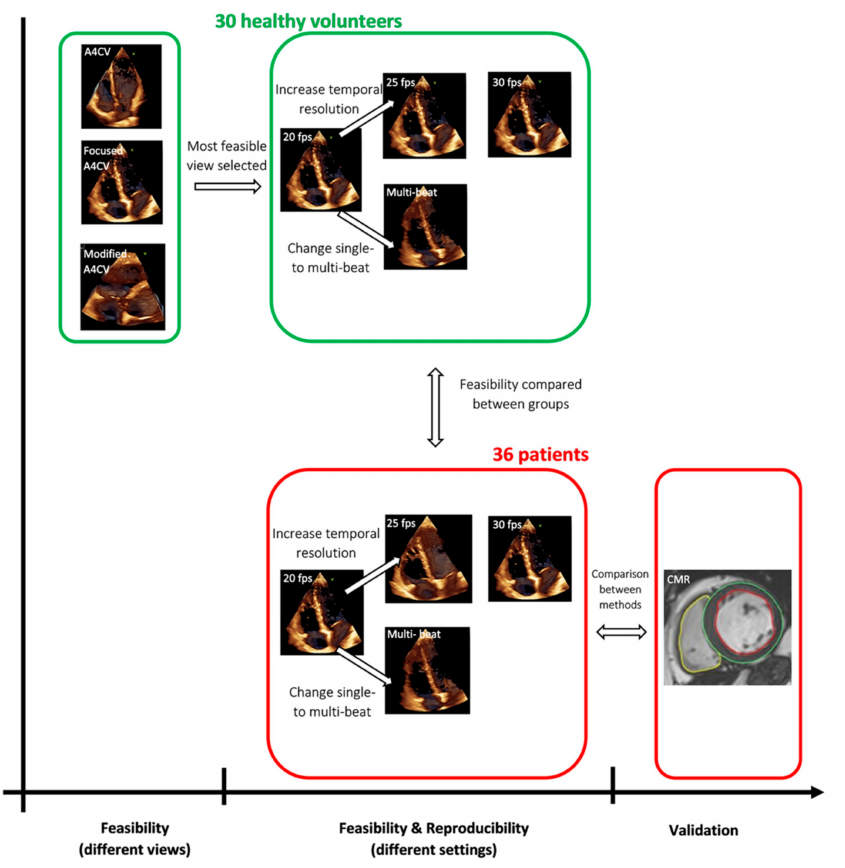
Figure 1. Schematic representation of the study design. (CMR image was reproduced Mikami et al. [17])